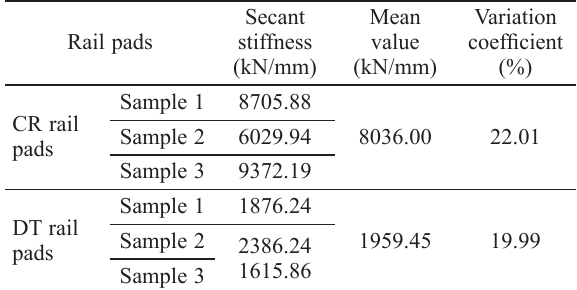
Table 3. Results obtained in the dynamic test for CR rail pads